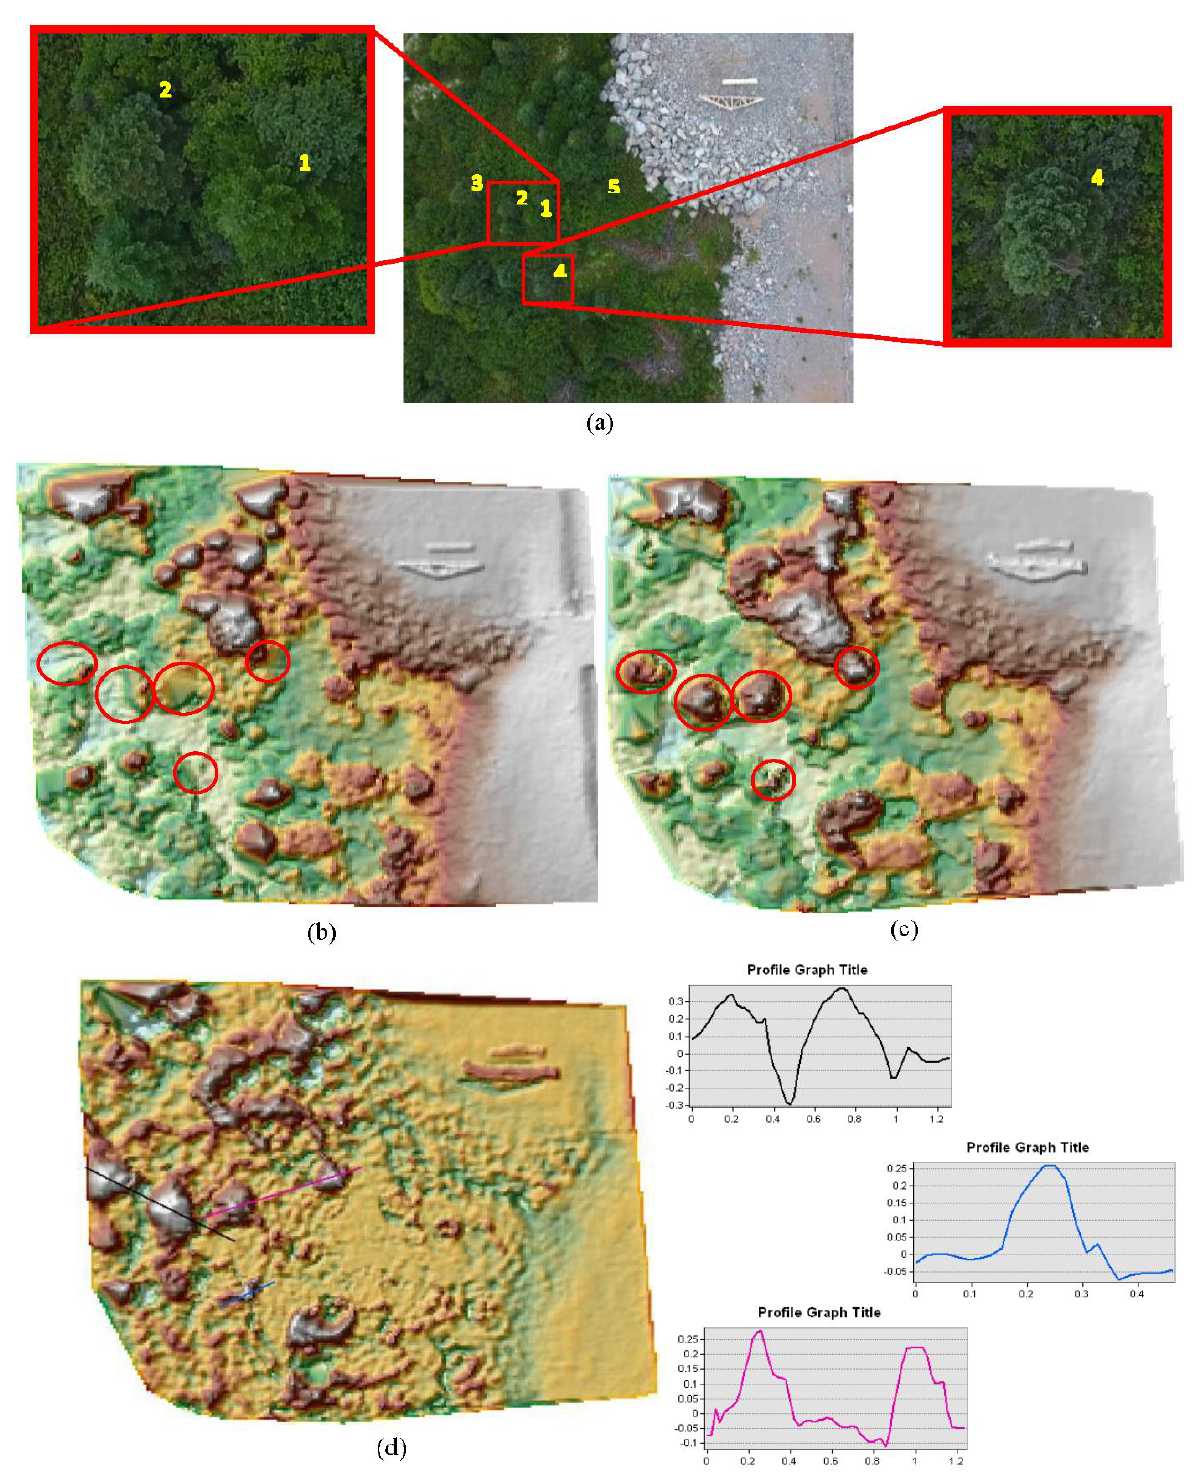
Figure 12. The image captured at the desired area ( a ), the generated DSM by Agisoft ( b ), as well as the proposed method, ( c ) are also shown from the second dataset. The subtraction of two DSMs, in addition to the profile graph, is also demonstrated ( d ).